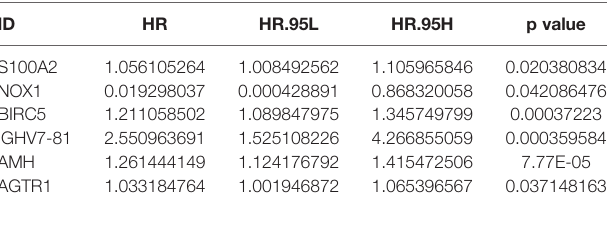
TABLE 3 | Univariate Cox regression analysis to fi ltrate key ARGs for BC patients.